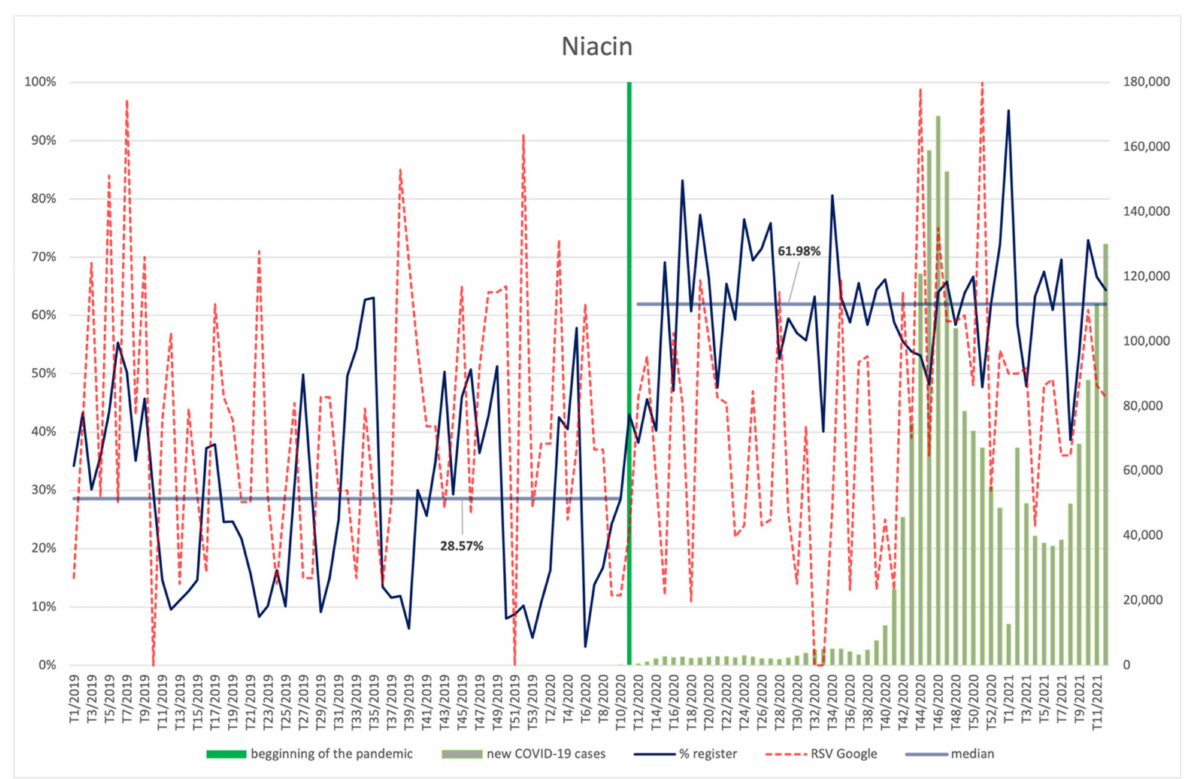
Figure 21. Comparison between the number of new registrations of products containing niacin, the number of COVID-19 cases, and the frequency of search for information on the ingredient in the Google browser. Each of the products was filed for the register significantly more often ( p <